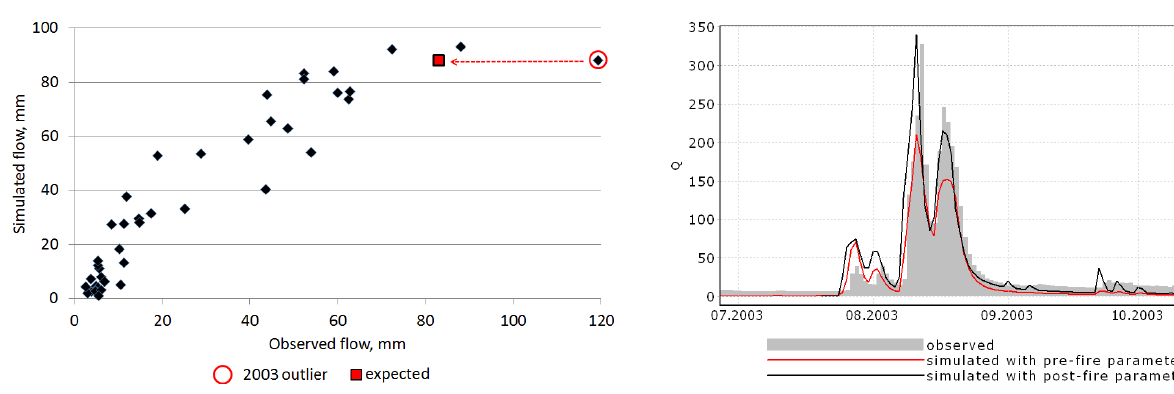
Figure 6. The dependence of observed and simulated flow depth in August for the Amalat River at Ust’-Antose with “stationary” parameters.